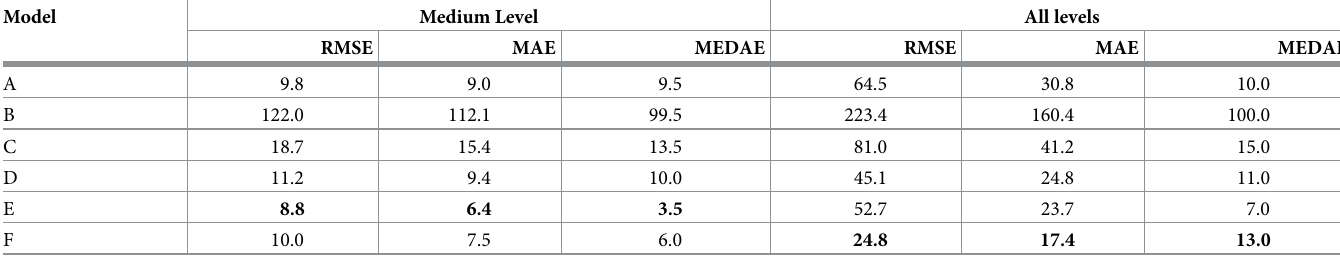
Table 15. Performance comparison of the six best models for the medium level of complexity and for the entire data set. Model